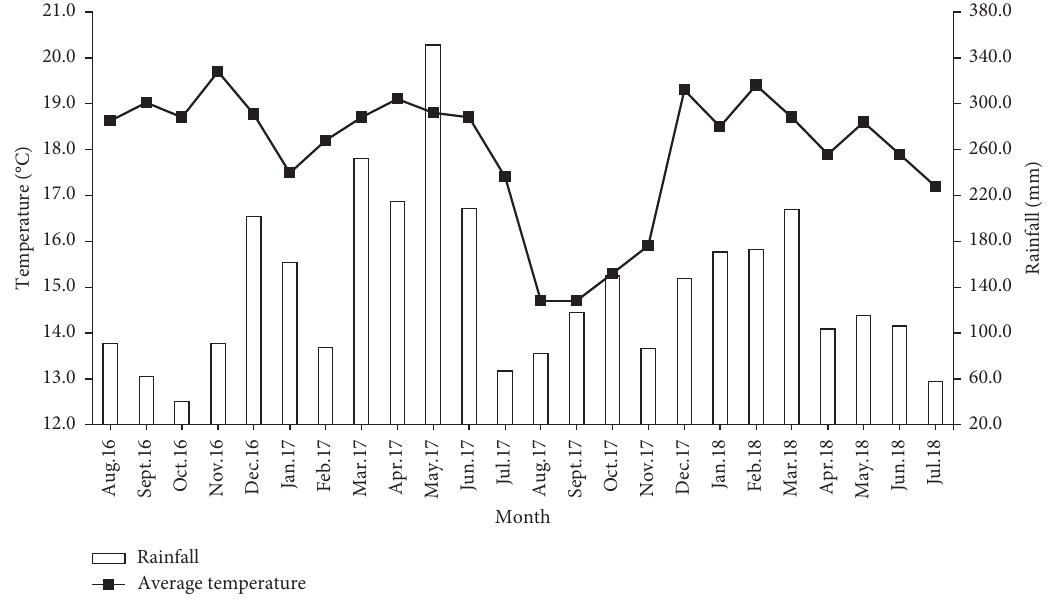
Figure 1: Monthly mean temperatures and rainfall from August 2016 through July